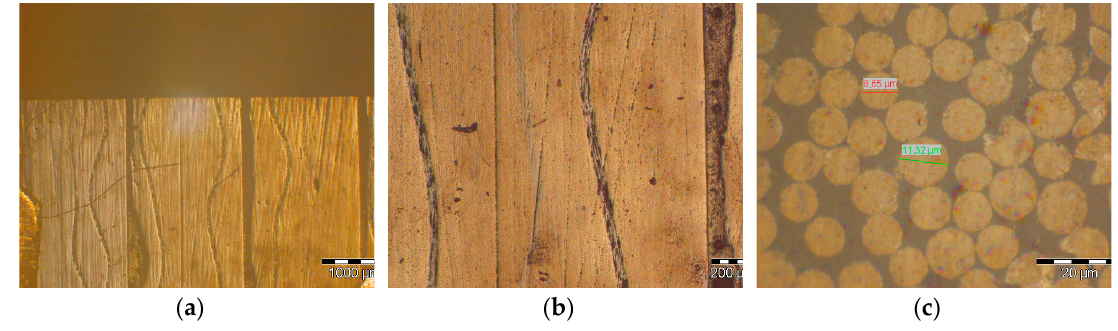
Figure 12. Light optical microscope (LOM) images of stacks of Panel A at different magnifications ( a ) 23×, ( b ) 75×, ( c ) 1500×.